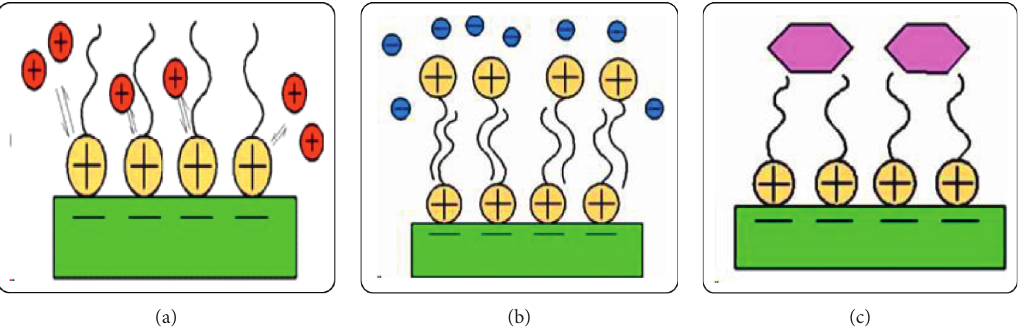
Figure 15: Mechanism of cation (a), anion (b), and organic (c) removal by cationic surfactants on the zeolite surface